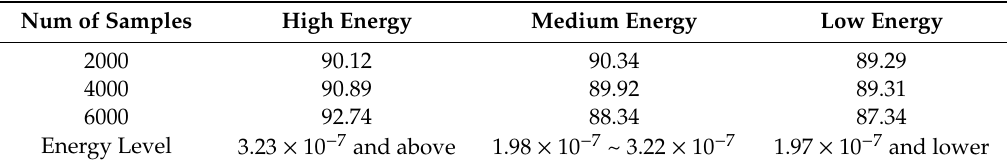
Table 4. Accuracy of energy classification of SI’s.